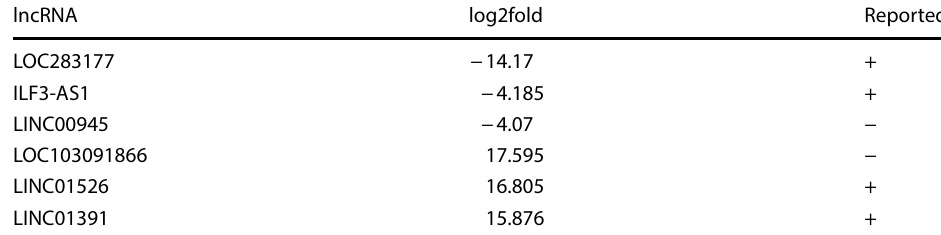
Table 9 Top three downregulated and upregulated lncRNA transcripts in OS-EP compared to OS-P